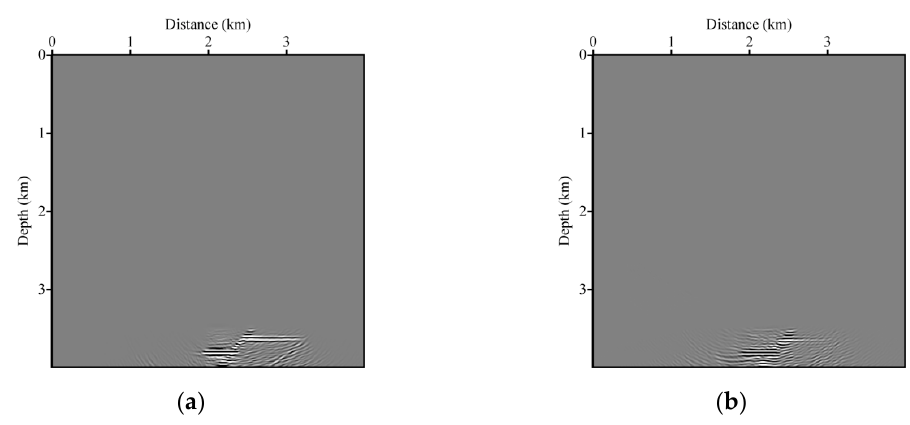
Figure 12. ERTM images based on the SVDWE: ( a ) PP imaging; ( b ) PS imaging. In the last experiment, a field data is utilized to confirm the effectiveness of our method. Figure 13 displays the migration velocity model that has 940 × 300 grid points with a 20 × 20 m 2 element. There are 240 sources unevenly distributed at the free surface. Figure 14 show some shot gathers whose maximum recording time is 5 s. Since we only have the vertical component of